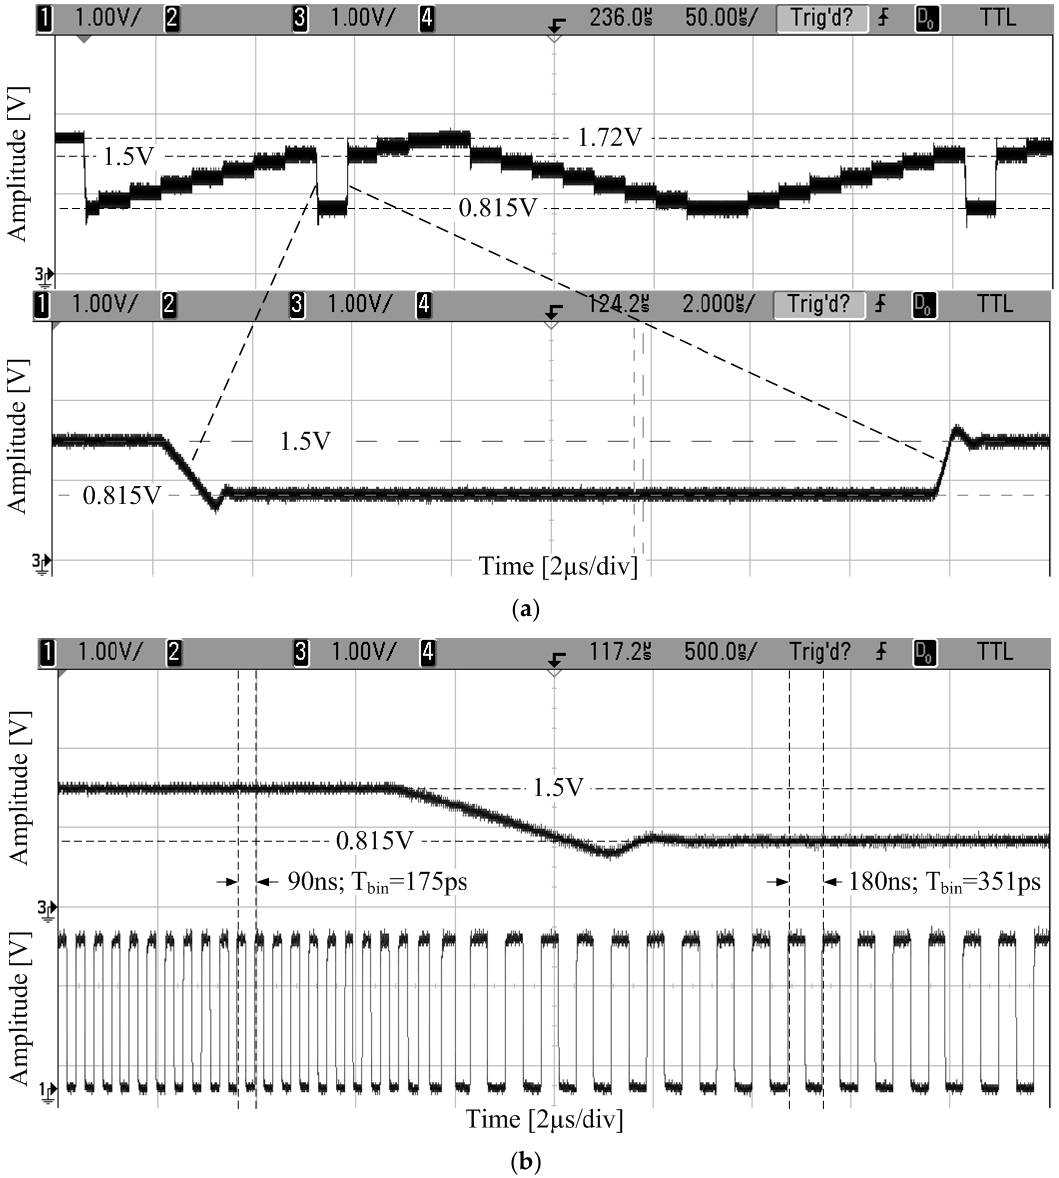
Figure 5. Time resolution programmability: ( a ) Reference voltage; ( b ) In-pixel voltage-controlled ring-oscillator (VCRO) frequency control.